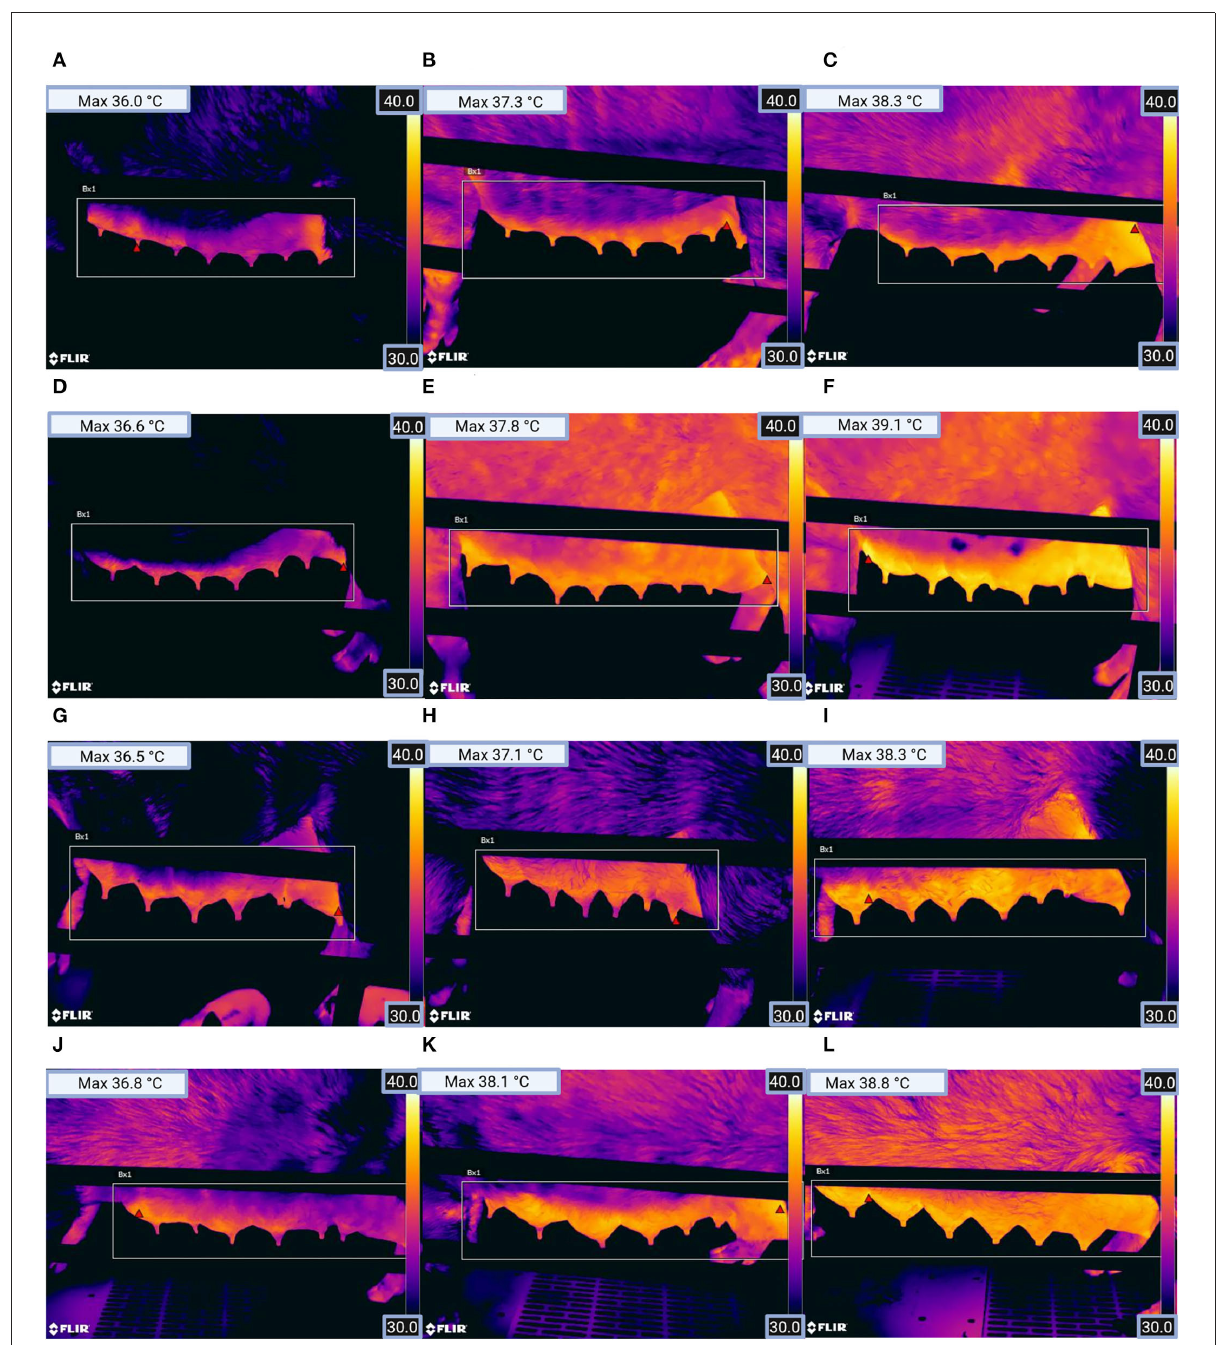
FIGURE2 Thermographic images from the left mammary gland of sows for (A) parity group 1 (healthy), (B) parity group 1 (clinically suspicious), (C) parity group 1 (diseased), (D) parity group 2 (healthy), (E) parity group 2 (clinically suspicious), (F) parity group 2 (diseased), (G) parity group 3 (healthy), (H) parity group 3 (clinically suspicious), (I) parity group 3 (diseased), (J) parity group 4 (healthy), (K) parity group 4 (clinically suspicious), and (L) parity group 4 (diseased). The red triangle within the rectangle in the image shows the location of the pixel with the highest temperature (see Max temperature top left in the picture). (Figure was created with